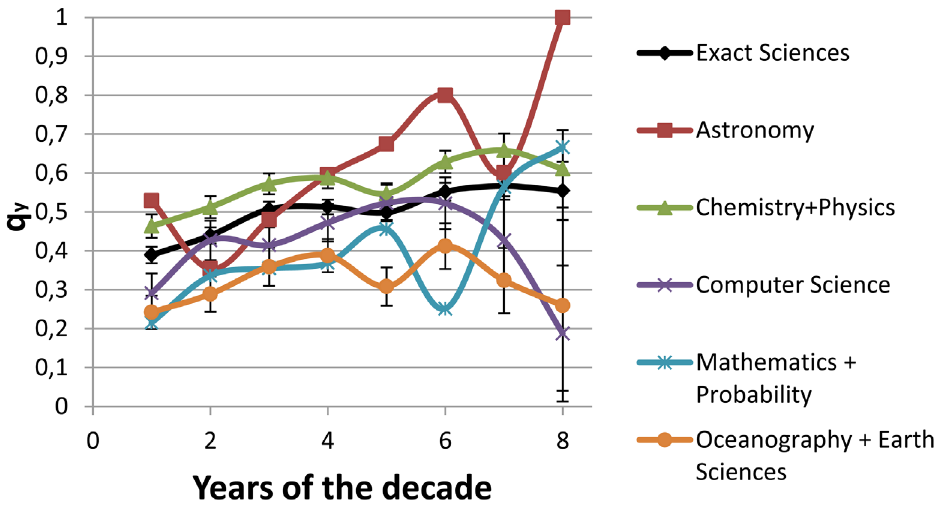
Fig 8. Proportion of A-A publications with regard to the publications of the advisee ( q y ) for decade D3 for the Exact Sciences and the five clusters per subareas (according to the dendrogram).